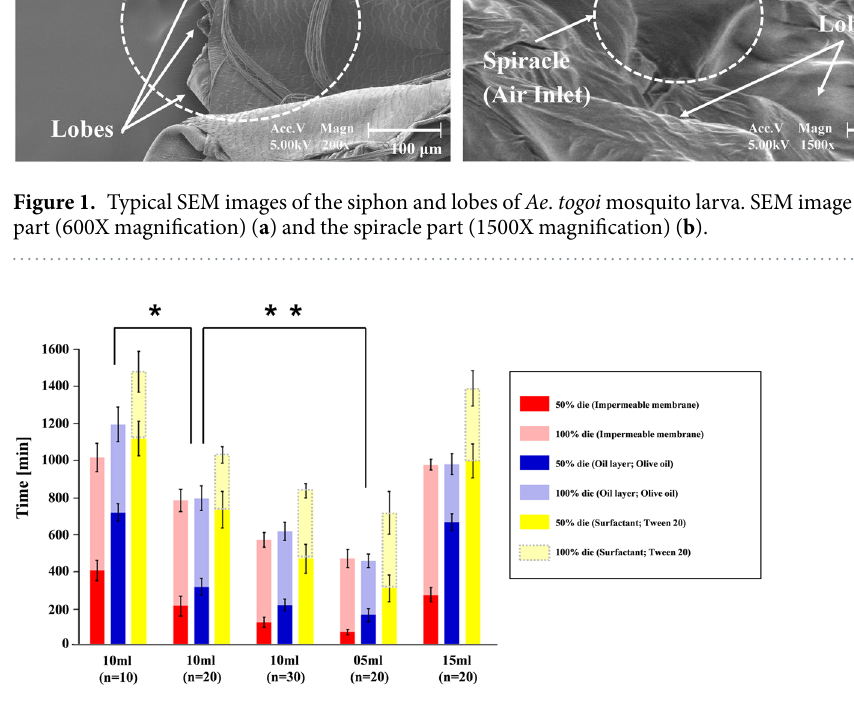
Figure 2. Comparison of the survival times for three treatments. [1] impermeable membrane (red bar), [2] oil layer (blue bar), [3] surfactant (yellow bar). The error bar represents the standard deviation ( * P < 0.05, ** P < 0.05, n =